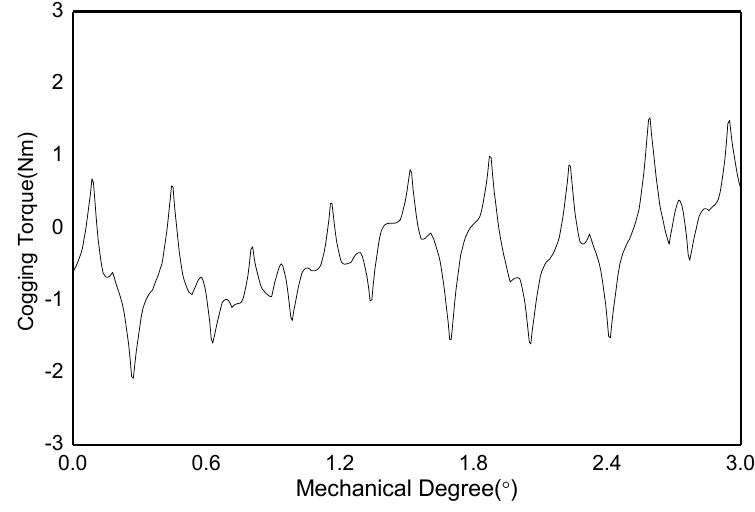
Figure 22. Waveform of the cogging torque.